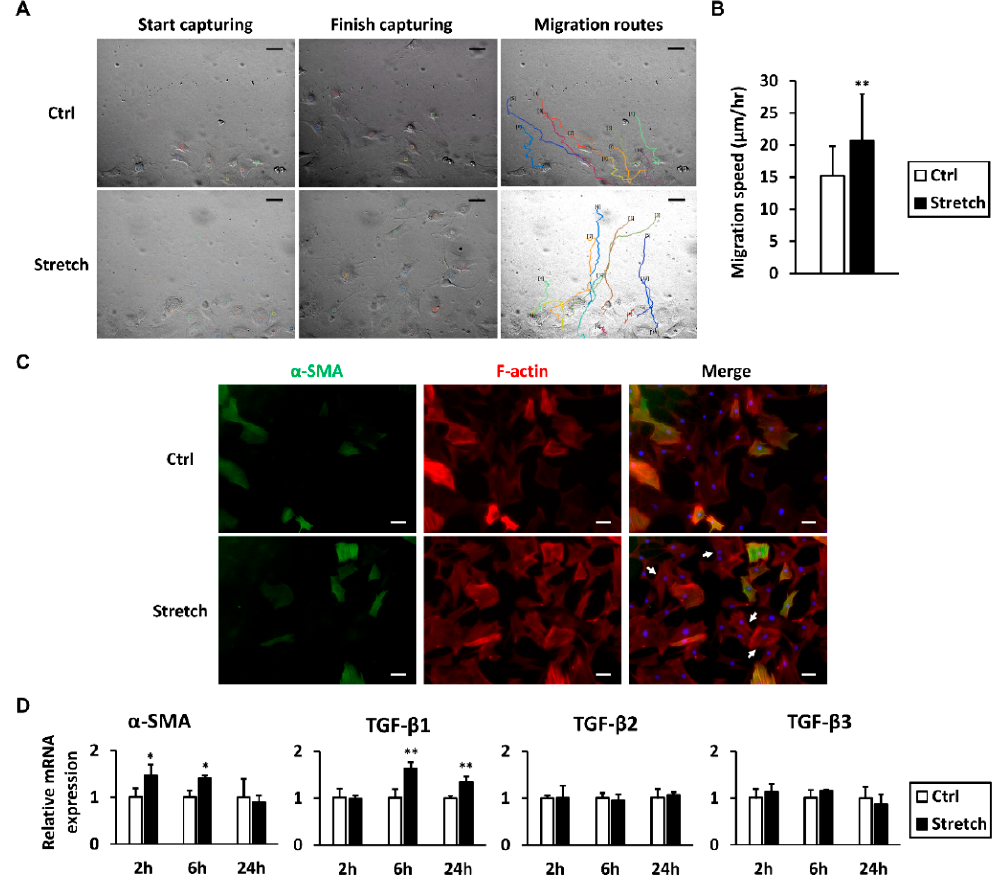
Figure 6. Mechanical stretch promotes tenocyte characteristics. ( A ) Motility of tenocytes subjected to mechanical stretch was analyzed using a wound healing assay. Wounds were created before stretch, and wound closure was monitored in real time up to 24 h. Migration routes were delineated using time-lapse videos. Each line represents the path of a different cell; ( B ) Migration speed of randomly chosen cells was calculated ( n = 70); ( C ) F-actin and α -SMA were fluorescently labeled immediately after the stretch session. After stretch, F-actin in α -SMA-negative tenocytes were sharper than those in the non-stretched control group (arrows); ( D ) The mRNA expression levels of α -SMA and TGF- β s were measured 2, 6, and 24 h after stretch began ( n = 4). Data are presented as the mean ± SD. Statistical significance is shown as * p < 0.05 or ** p < 0.01 compared to the non-stretched control group. Scale bar = 50 μ m.